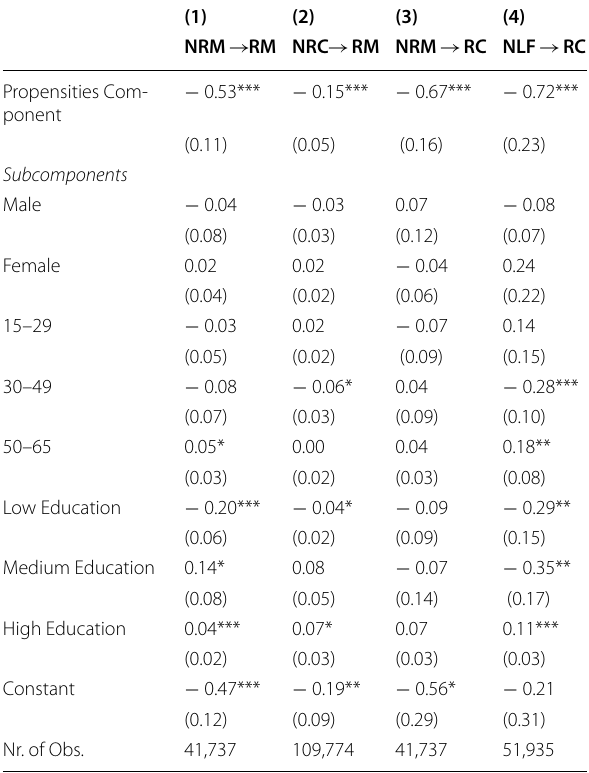
Table 5 Sub-Decomposition of Inflow Rate Changes between phase I and